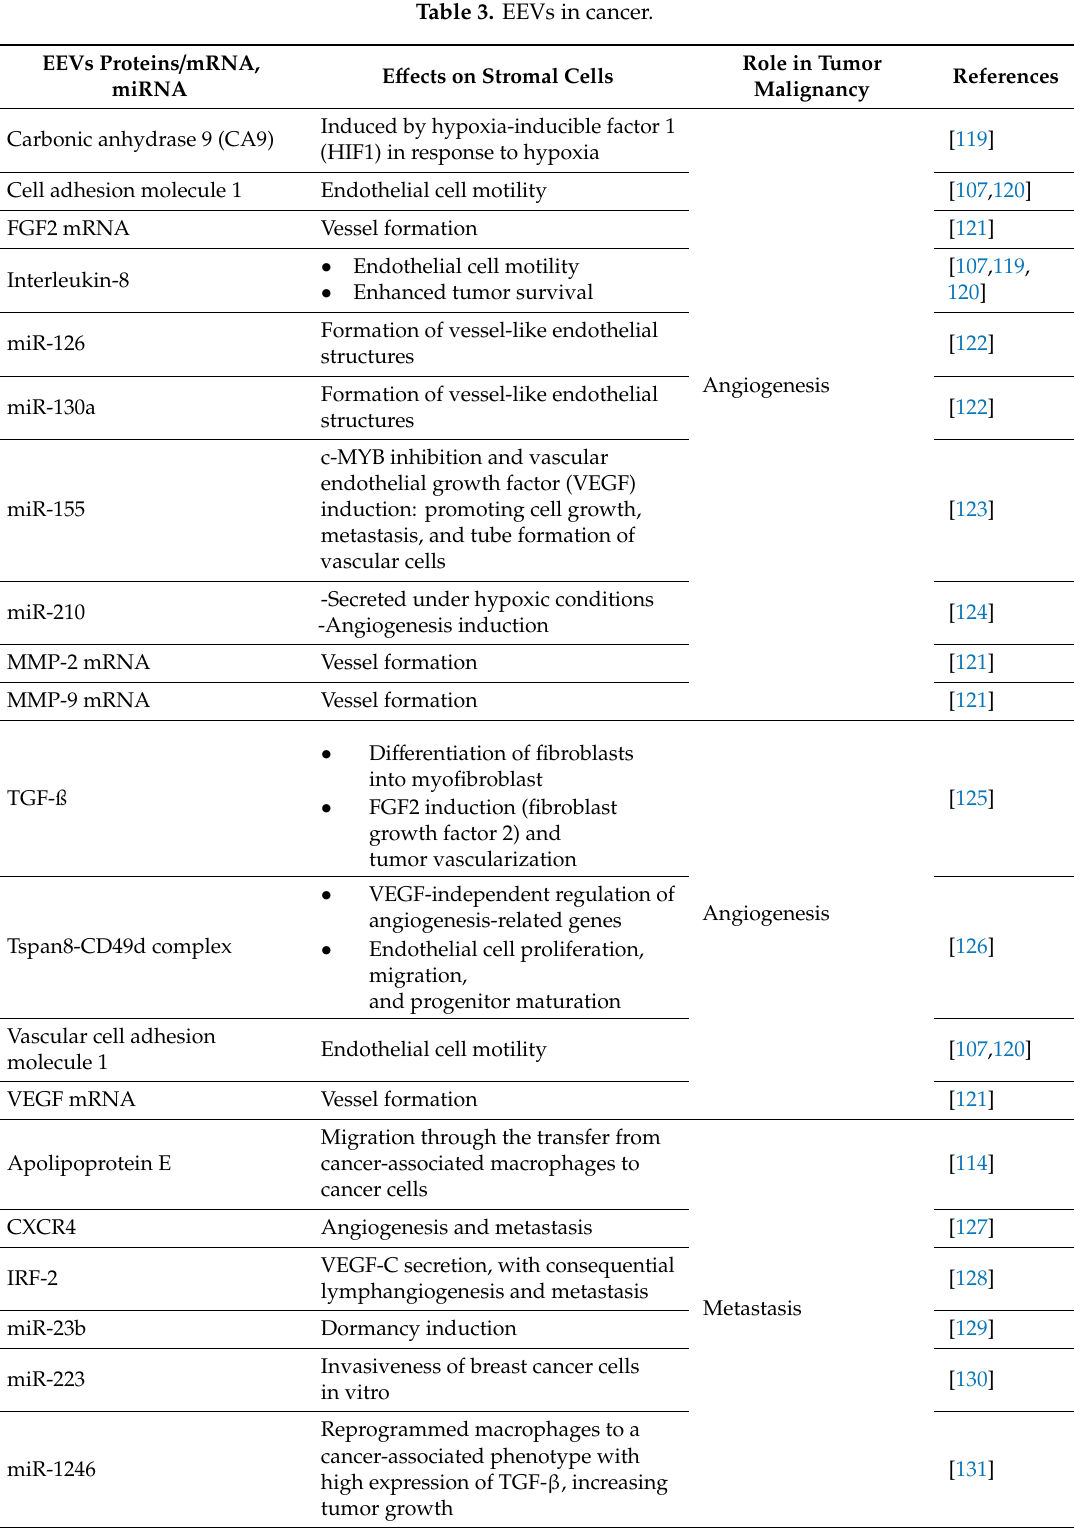
Table 3. EEVs in